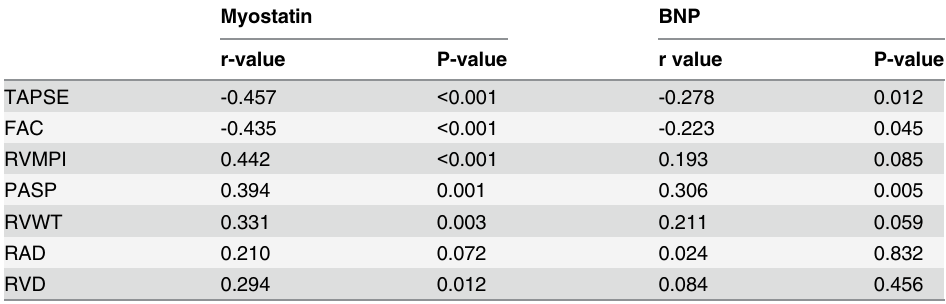
Table 3. Correlation Coefficients of Plasma Myostatin and BNP levels with Echocardiographic Param- eters in COPD Patients. Myostatin